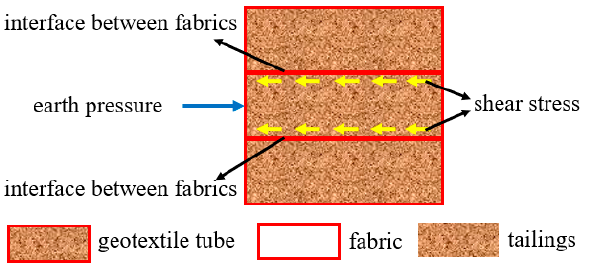
Figure 3. Force diagram of the interface between geotextile tubes.